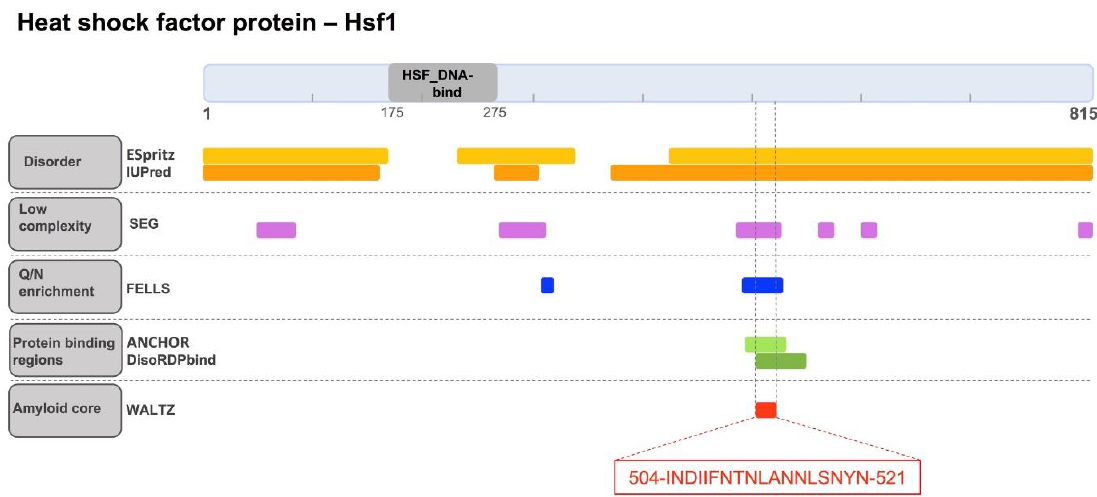
Figure 1. The cryptic amyloid core of heat shock factor 1 protein (Hsf1) in Saccharomyces cerevisiae ( S. cerevisiae ). Hsf1 diagram showing the location of the identified Pfam domain (grey), predicted disordered regions (orange), low complexity segments (violet), glutamine/asparagine (Q/N)-rich regions (blue), protein binding sites (green), and the cryptic amyloid core (red). The sequence of the amyloid core is shown in the red box. Hsf1: heat shock protein 1.